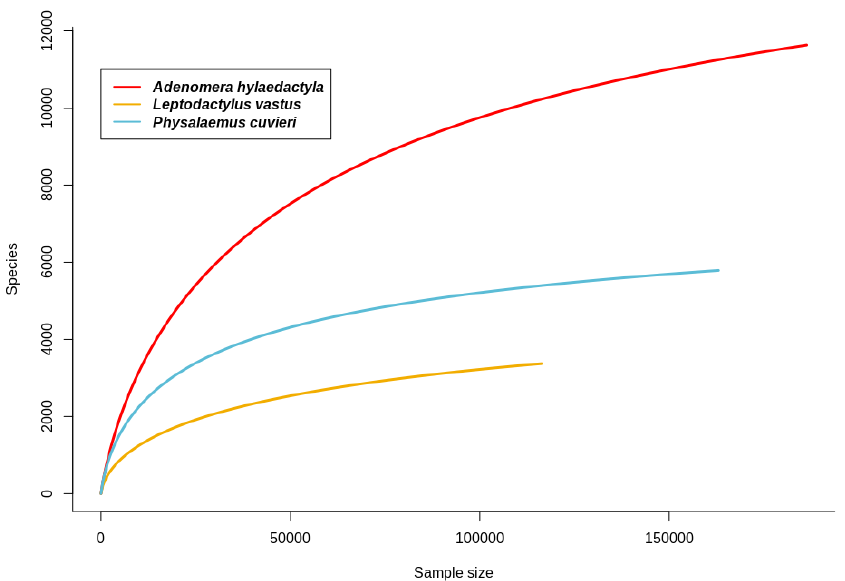
Figure 3. Rarefaction curves for observed amplicon sequence variants (ASVs) in foam nests from neotropical frogs A. hylaedactyla , L. vastus , and P. cuvieri . Table 2. Richness and alpha diversity of amplicon sequence variants (ASVs) in the foam nests of A. hylaedactyla , P. cuvieri , and L. vastus